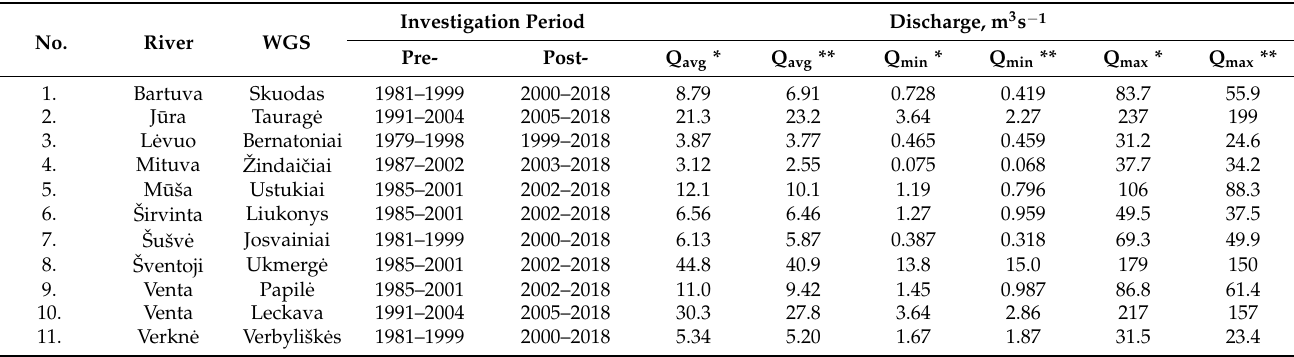
Table 2. Characteristics of the water gauging